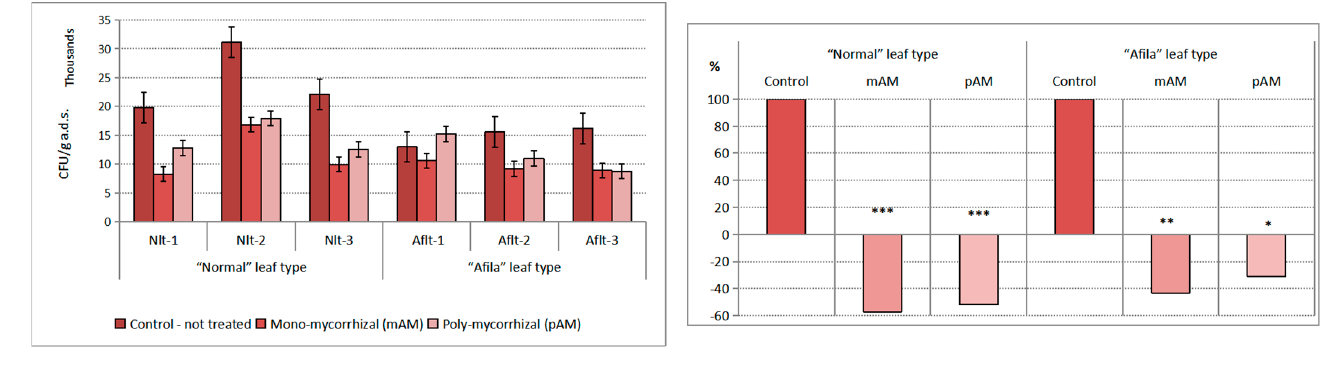
Figure 1. Average population density of the trophic group Micromycetes (CFU ∙ g − 1 absolutely dry soil) in the rhizosphere communities formed after introduction of AM fungi: (mAM) mono-mycorrhizal and (pAM) poly-mycorrhizal inoculants. ( a ) Average values for the particular varieties of garden pea with “normal” leaf type (Nlt-1—cvr. Marsi, Nlt-2—cvr. Plovdiv and Nlt-3—cvr. 22/16-n) and “afila” leaf type (Aflt-1—cvr. 22/16-af, Aflt-2—cvr. Kazino and Aflt-3—cvr. Echo). Error bars indicate standard error of the mean (SE). ( b ) Relative values of the differences in the population levels of the trophic group Micromysetes (%) compared to the un- treated controls, including means for both “normal” leaf type and “afila” leaf type genotypes. The significance of the differences between means of controls and treatments were calculated with the two-tailed Student’s t -test (at df—10; *** p < 0.01, ** p < 0.05 and * p < 0.10).